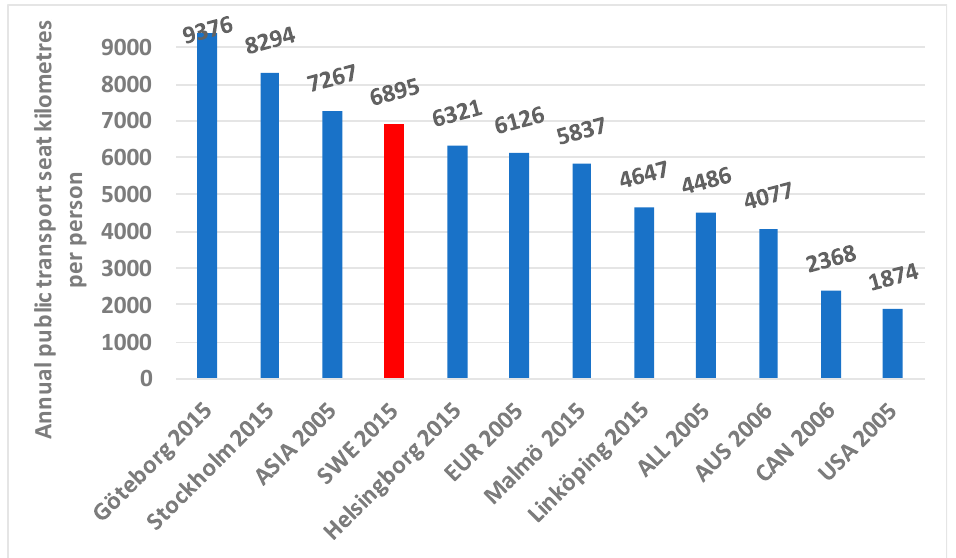
Figure 8. Annual public transport seat kilometres of services per person in five Swedish cities (2015) compared to a sample of global cities (2005–2006).